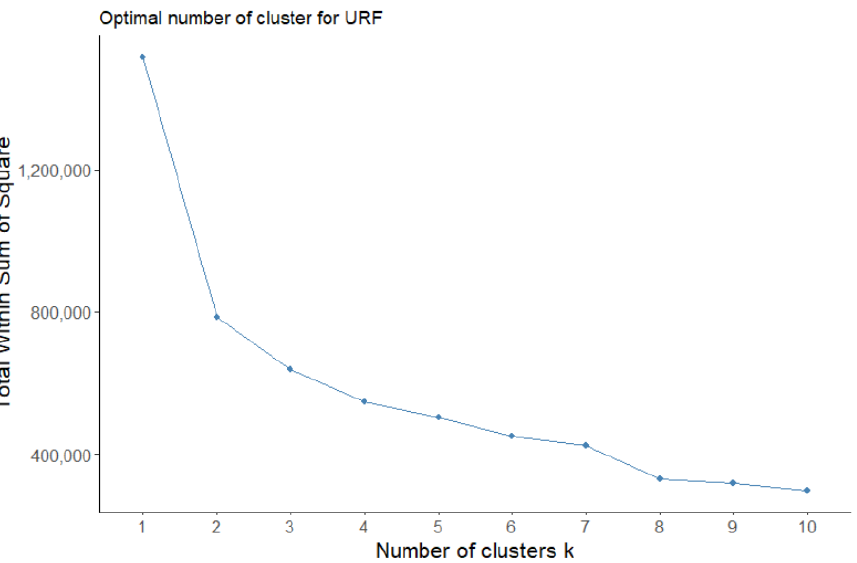
Figure 5. Elbow method of the selected variables using partitioning around medoids clustering, where three and four clusters were selected.